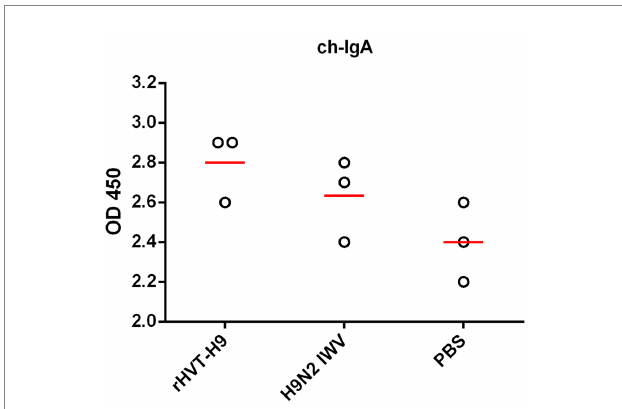
FIGURE 4 Mucosal immunity after vaccination in chickens with PTAs. Lavage liquids from nasal cavity and trachea of chickens with PTAs ( n = 3/group) were harvest twenty-eight-day after vaccination and used to quantify H9 HA-specific ch-IgA using indirect ELISA. Significant differences were calculated using Tukey test, posed ANOVA. p ≤ 0.05 was considered to be significant.